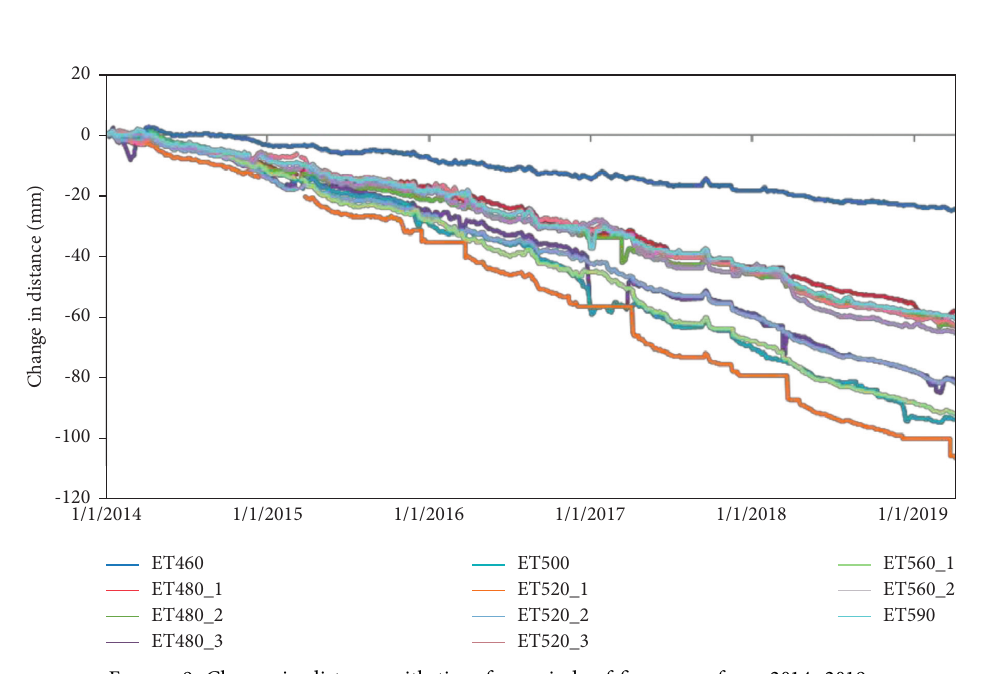
Figure 9: Change in distance with time for periods of five years, from 2014 ∼